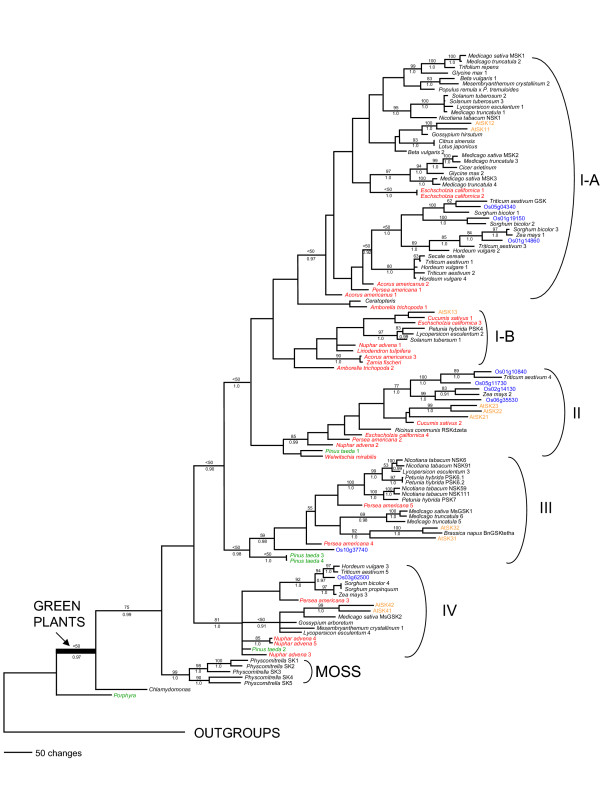
Strict consensus tree of 17 most parsimonious trees (length = 11641; CI = 0.1522; RI = 0.5789) of GSK3/SHAGGY-like kinase homologs from plants, animals, protists, and fungi based on sequence alignment of the 1044 nucleotides encoding the catalytic domain and part of the 3' end of the sequences. Numbers above the branches are bootstrap values; only values over 50% are indicated. Numbers below the branches are posterior probabilities from the Bayesian analysis; only values over 0.90 are indicated. Orange labels indicate GSK homologs from Arabidopsis, and blue labels designate rice sequences. GSK homologs from FGP ESTs are labeled in red. Pinus ESTs are labeled in green.